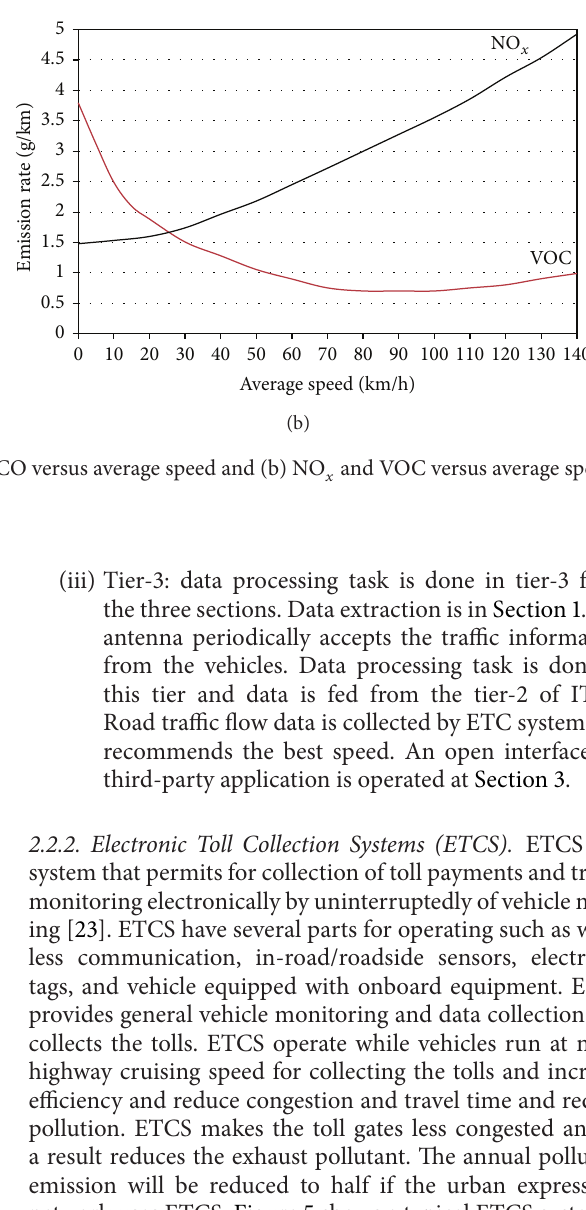
Figure 3: Typical relation between emission and average speed. (a) CO versus average speed and (b) NO 𝑥 and VOC versus average speed.